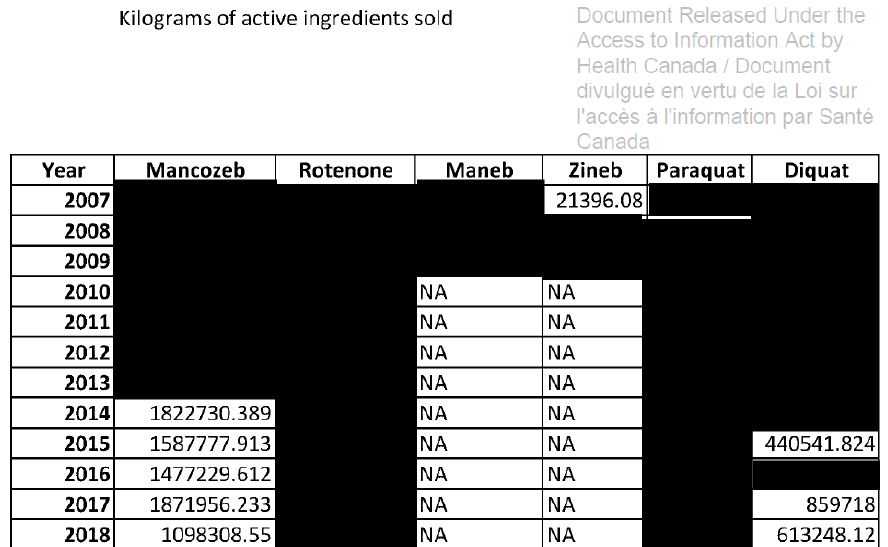
Figure 2. Canadian sales data of six pesticides linked to Parkinson’s disease received from Health Canada following a request made under the Access to Information Act. The blackout data is censored, and NA means Not